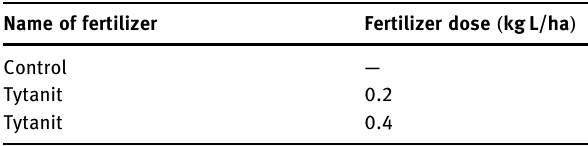
Table 1: Versions of the